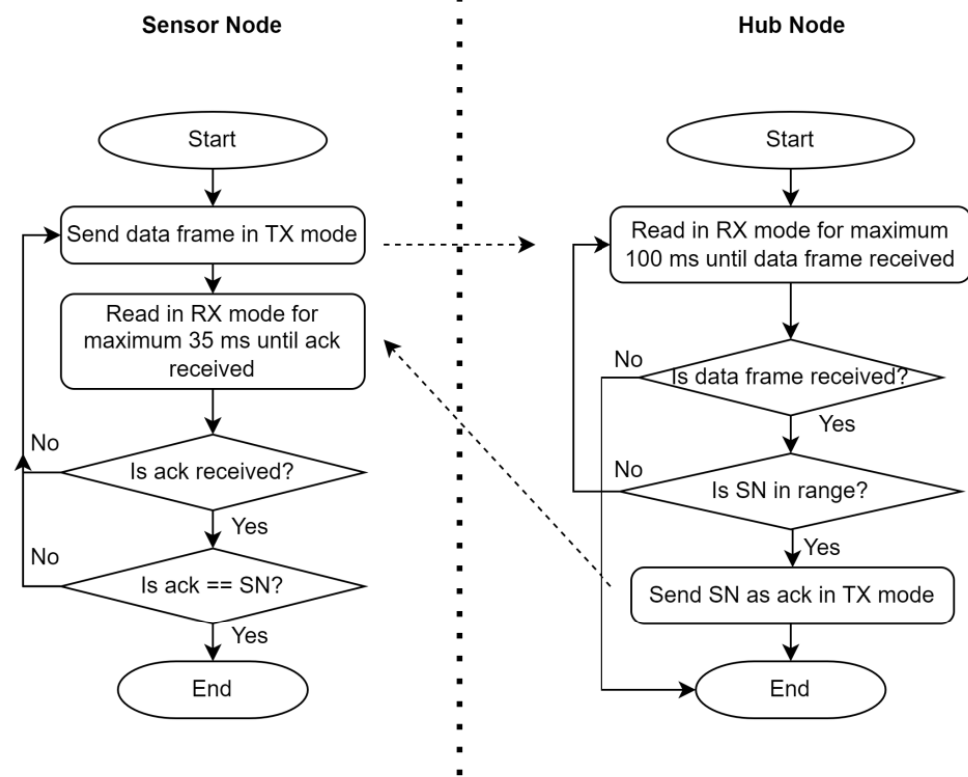
Figure 7. Flowchart of the custom LoRa communication protocol between the sensor and hub nodes for lower power-consumption rates.